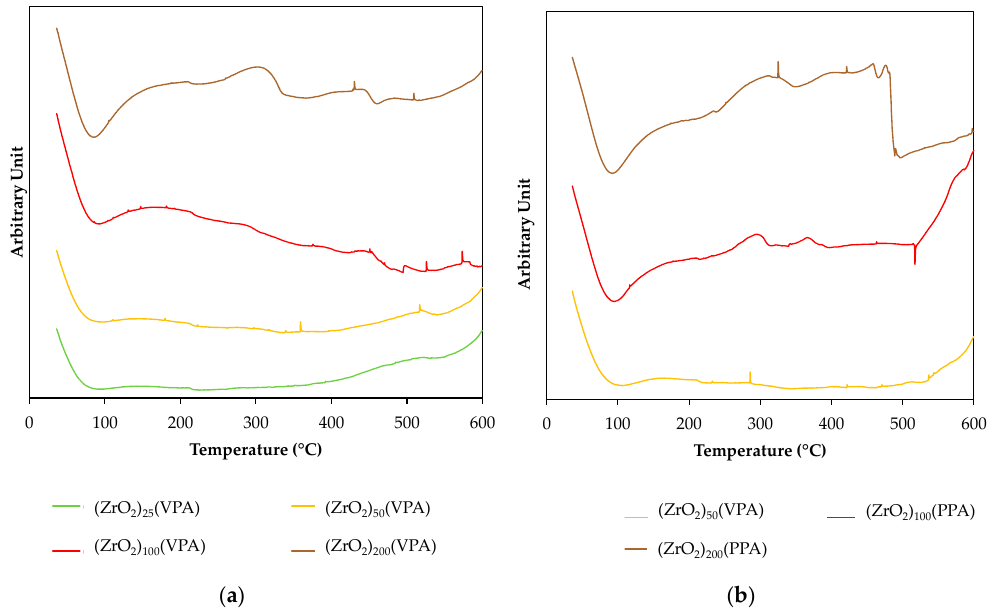
Figure A2. Differential Scanning Calorimetry analysis of ( a ) (ZrO 2 ) x (VPA) and ( b ) (ZrO 2 ) x (VPA) Samples (Zr/P ratio ( x ) = 50, 75, 100, 200) in the range of 25–600 °C.